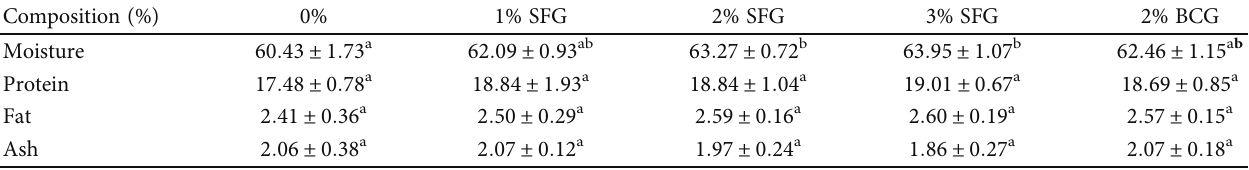
Table 2: Proximate composition of sausages emulsion with the addition of di ff erent gelatin levels. Composition (%)